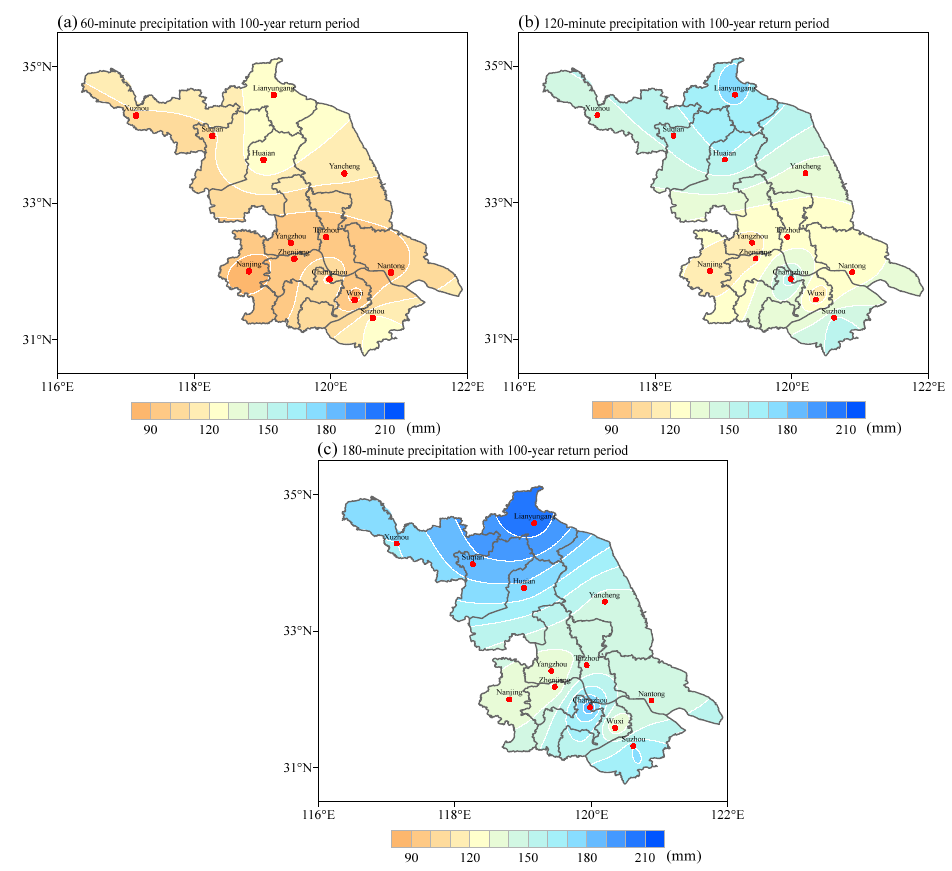
Figure 7. Precipitation distributions in Jiangsu Province for ( a ) 60 min, ( b ) 120 min, and ( c ) 180 min rainstorms in 100-year return period.